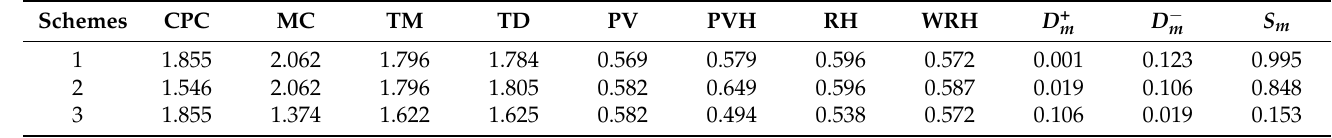
Table 11. Results of the calculations adopting the TOPSIS method for the RCC gravity